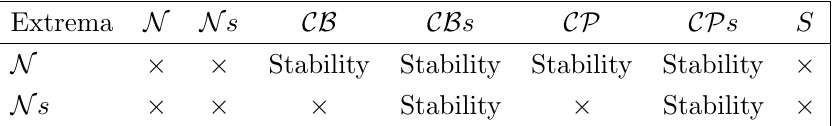
Table 1 . Stability of extrema of types N and N s in the potential. For a given pair of extrema, \Stability" means that if one of them is a minimum, the other is necessarily above it. A pair of \Unde(cid:12)ned" extrema (marked in the table with \ (cid:2) ") means that both of them can be